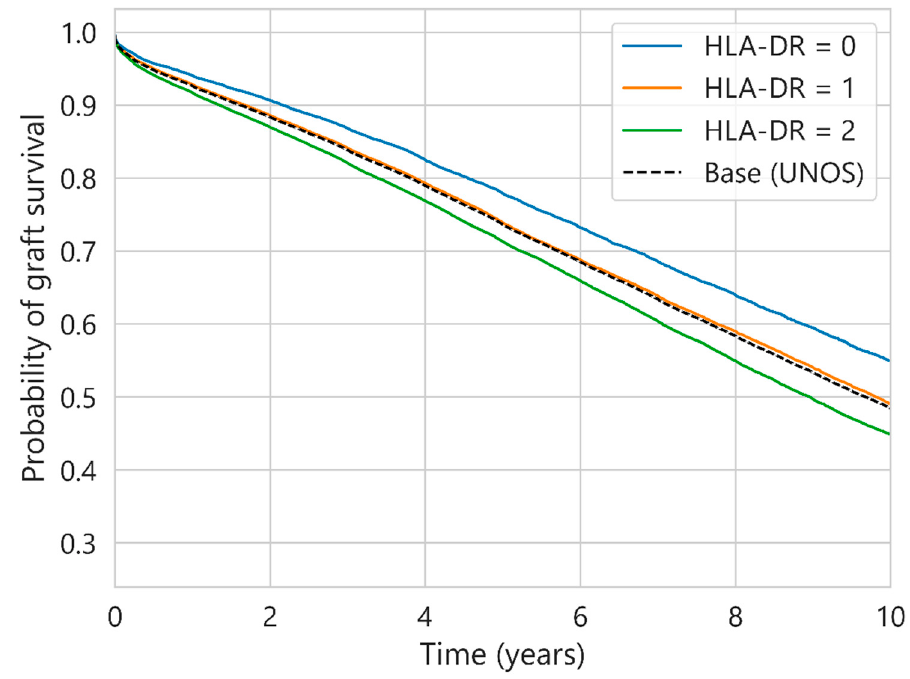
Figure 4. Ten-year survival probability for UNOS considering different HLA-DR mismatch values. Survival analysis for aHLA (HLA-A + HLA-B + HLA-DR), with values between 0 and 6, which offers differences in behaviour as pointed out by some authors